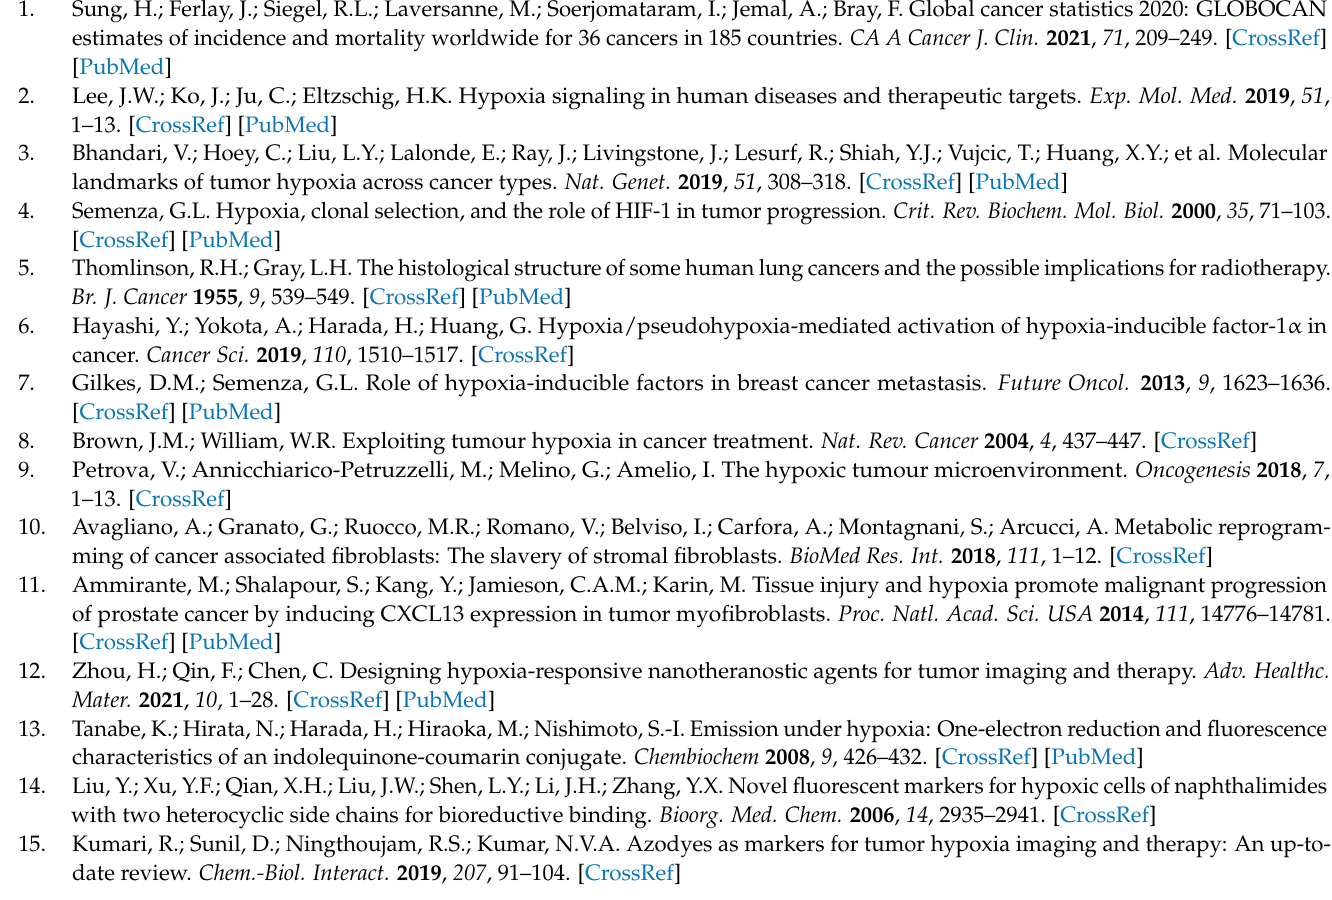
Figure S9. Fluorescent spectra of dye, the complex before the addition of SDT, and after 20 min of exposure with the addition of SDT for systems with Rh6G (a), RhB (b), and Rh123 (c). C [dye] = 1 µ M, C [ L ] = 1 µ M, C [SDT] = 100 µ M, PBS buffer (pH 7.4) at 37 ◦